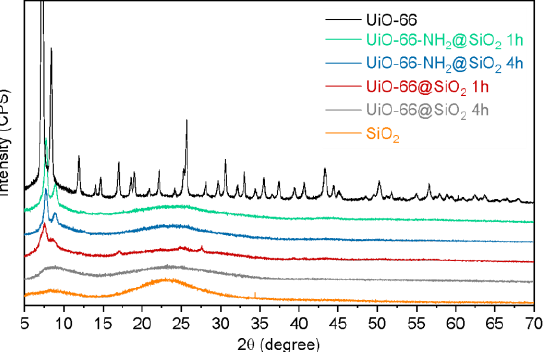
Figure 4. XRD patterns collected for intact UiO-66 nanoparticles, SiO 2 nanoparticles, and TEOS- treated UiO-66@SiO 2 and UiO-66-NH 2 @SiO 2 samples. treated UiO-66@SiO 2 and UiO-66-NH 2 @SiO 2